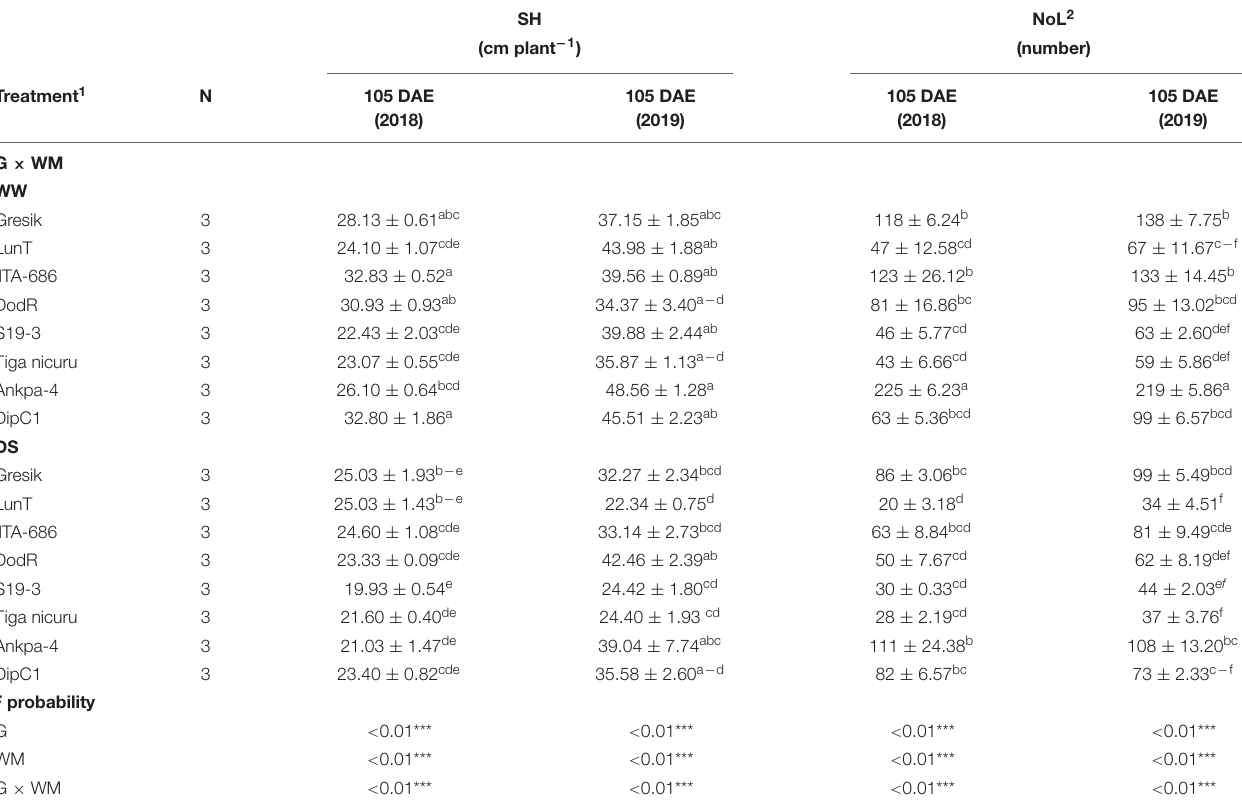
TABLE 2 | Analysis of variance (ANOVA) for SH, and NoL at 105 DAE of eight bambara groundnut genotypes, grown in soil-filled PVC columns in a rainout shelter under WW and DS in two seasons 2018 and 2019. SH